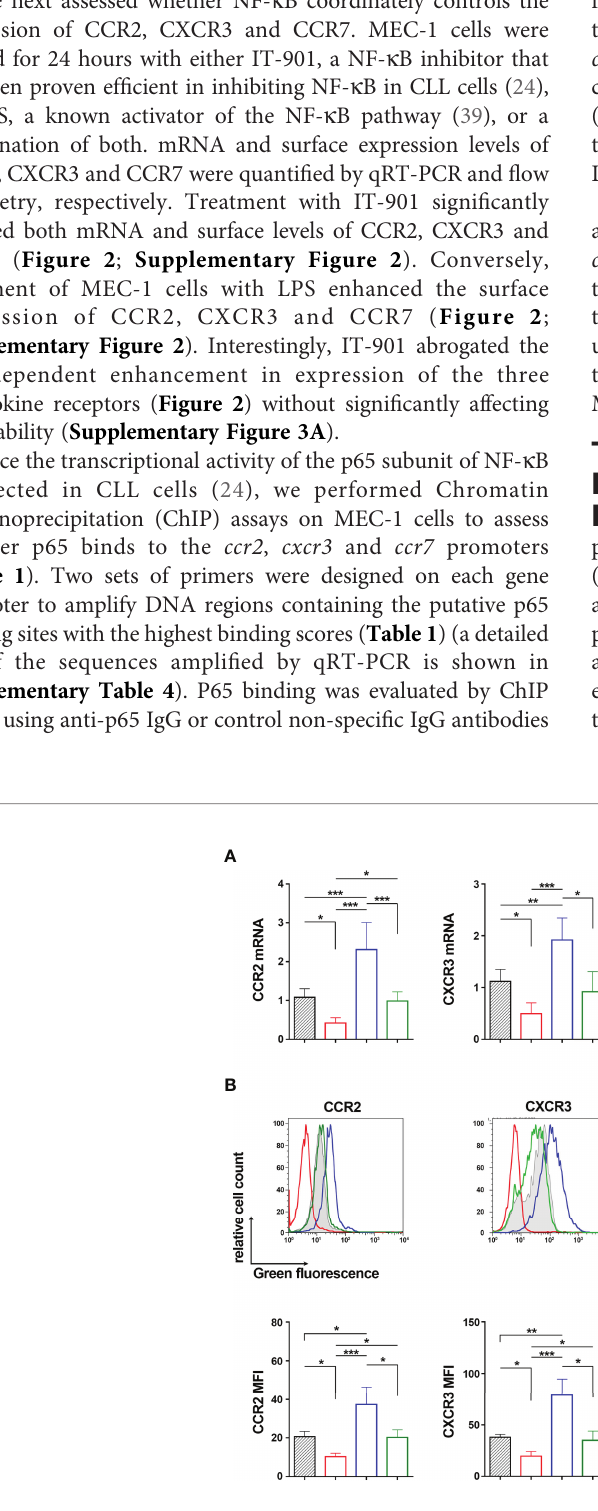
FIGURE 2 | NF- k B coordinately controls CCR2, CXCR3 and CCR7 expression in MEC-1 cells. Quantitative RT-PCR (A) and fl ow cytometric (B) analysis of CCR2, CXCR3 and CCR7 mRNA (A) and protein (B) in MEC-1cells treated with 1 m M IT-901 or 10 m M LPS or the combination of both for 24 h at 37°C. The relative gene transcript abundance was determined on triplicate samples using the ddCt method and normalized to HPRT1 (n independent experiments = 4). Representative fl ow cytometric plots are shown. Mean ± SD. Anova two-way test, Multiple Comparison. p ≤ 0.001, ***; p ≤ 0.01, **; p ≤ 0.05,